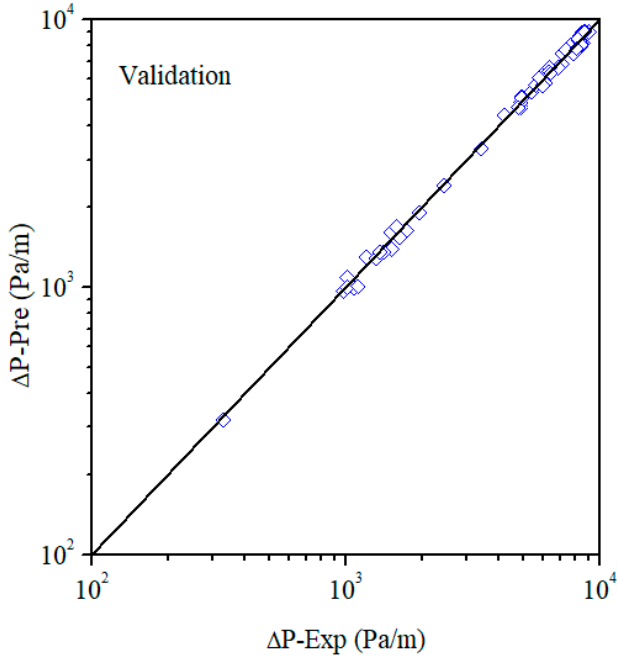
Figure 6. Comparison of predicted pressure drop with experimental values of validation dataset.